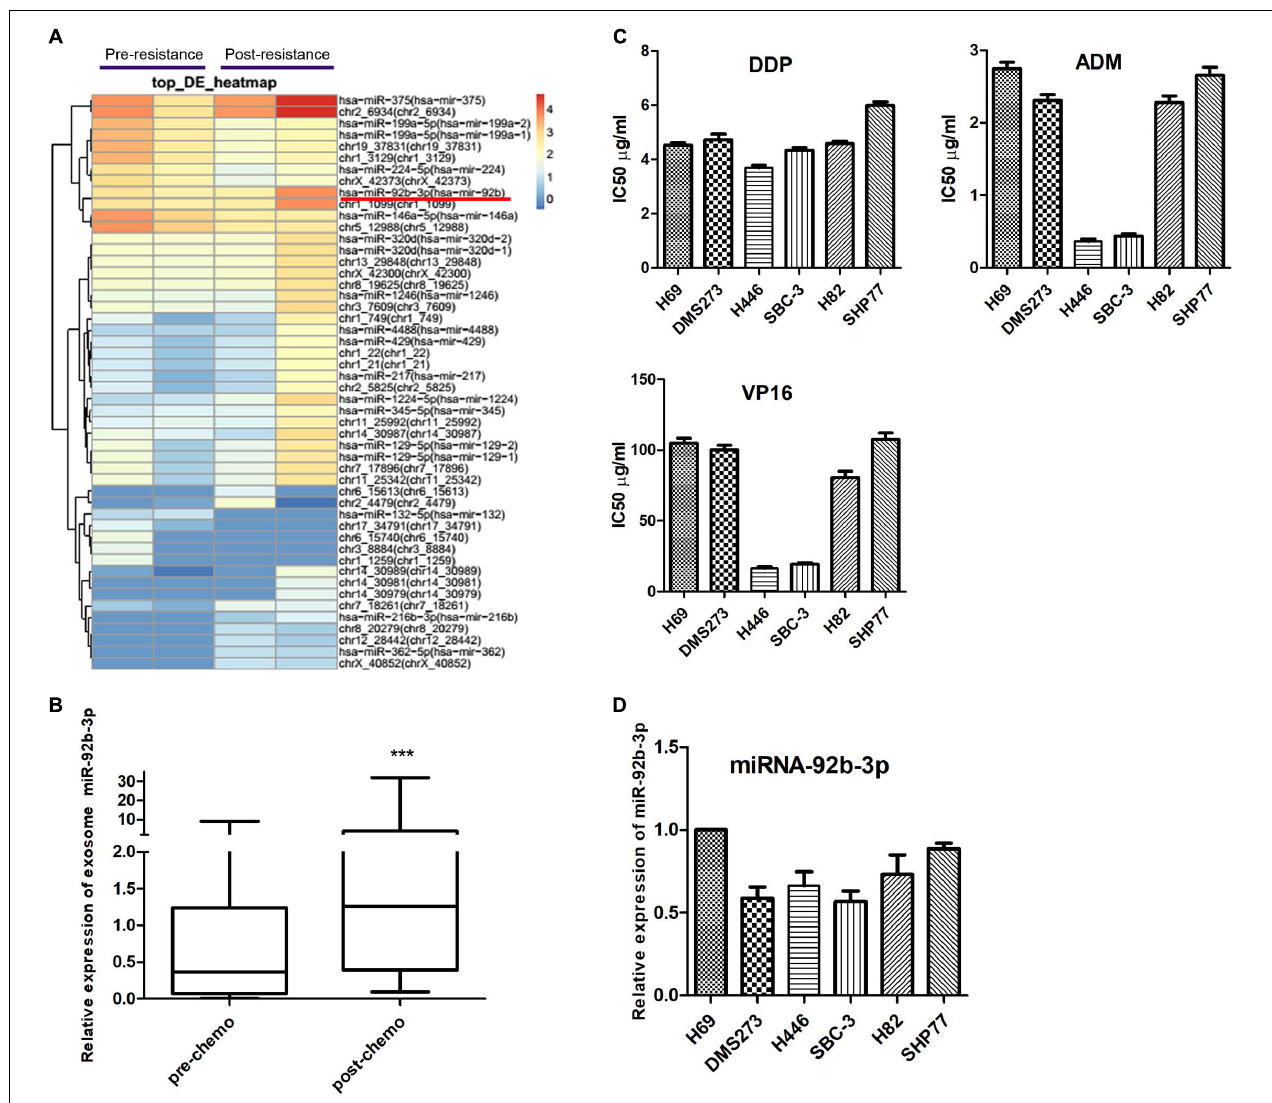
FIGURE 1 | Circulating miR-92b-3p is aberrantly up-regulated in SCLC chemoresistant patients. (A) The heatmap shows the top miRNAs with the largest changes (increased or decreased) in expression in plasma exosomes of two patients before and after developing chemoresistance. (B) The level of miR-92b-3p was higher in plasma exosomes from chemoresistant patients than from chemosensitive patients. *** P < 0.001. (C) IC50 values of DDP, ADM, and VP16 in SCLC cell lines. SBC-3 and H446 cells were relatively sensitive to chemotherapy drugs, while SHP77 cells were resistant to chemotherapy drugs. (D) MiR-92b-3p expression in SCLC cell lines. MiR-92b-3p expression was higher in chemoresistant SHP77 cells than in the other cell lines, whereas the lowest expression was observed in chemosensitive SBC-3 cells. (B–D) experiments were performed independently three times. SCLC, small cell lung cancer; miRNAs, microRNAs; DDP, cisplatin; ADM, adriamycin; and VP16,